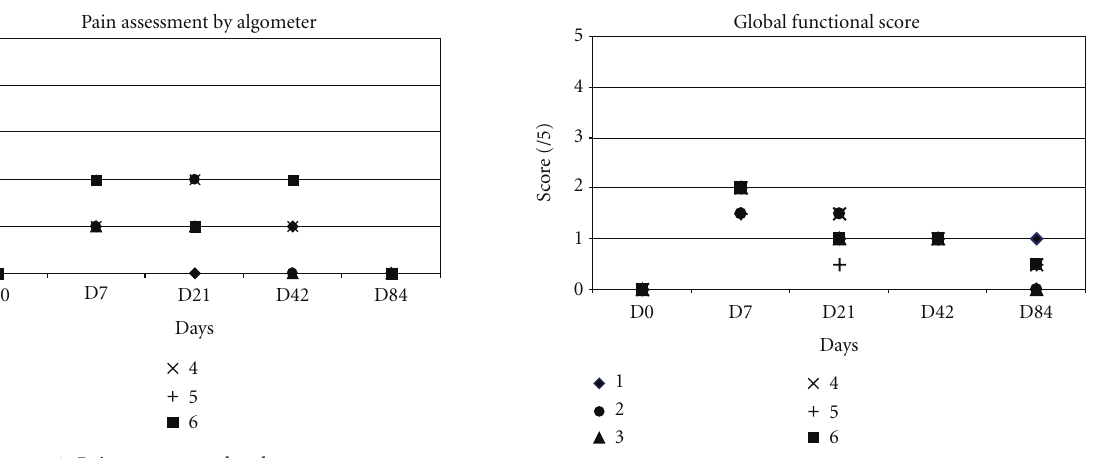
Figure 3: Global functional score of